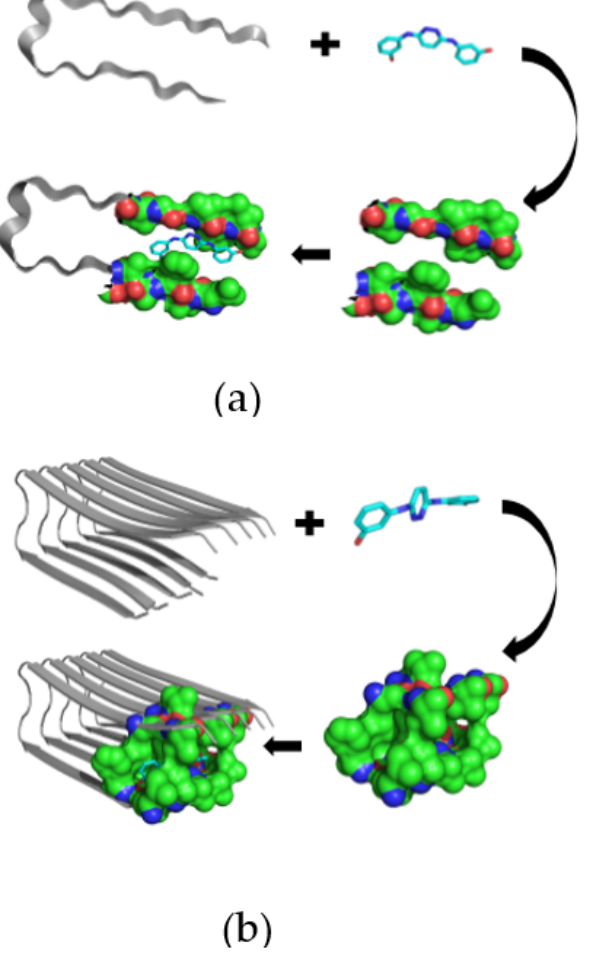
Figure 3. The predicted interaction of the RS-0406 molecule with Aβ as a monomer ( a ) or oligomer ( b ). The binding site is shown as a molecular surface predicted by the CASTp algorithm (Shityakov et al., unpublished).